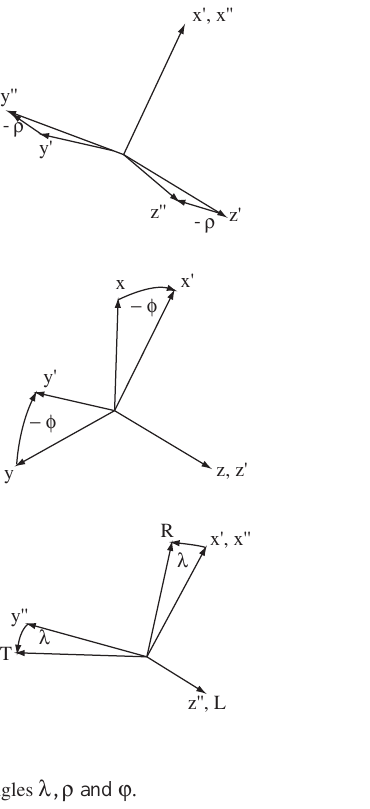
Figure 6. Euler’s angles λ , ρ and ϕ.